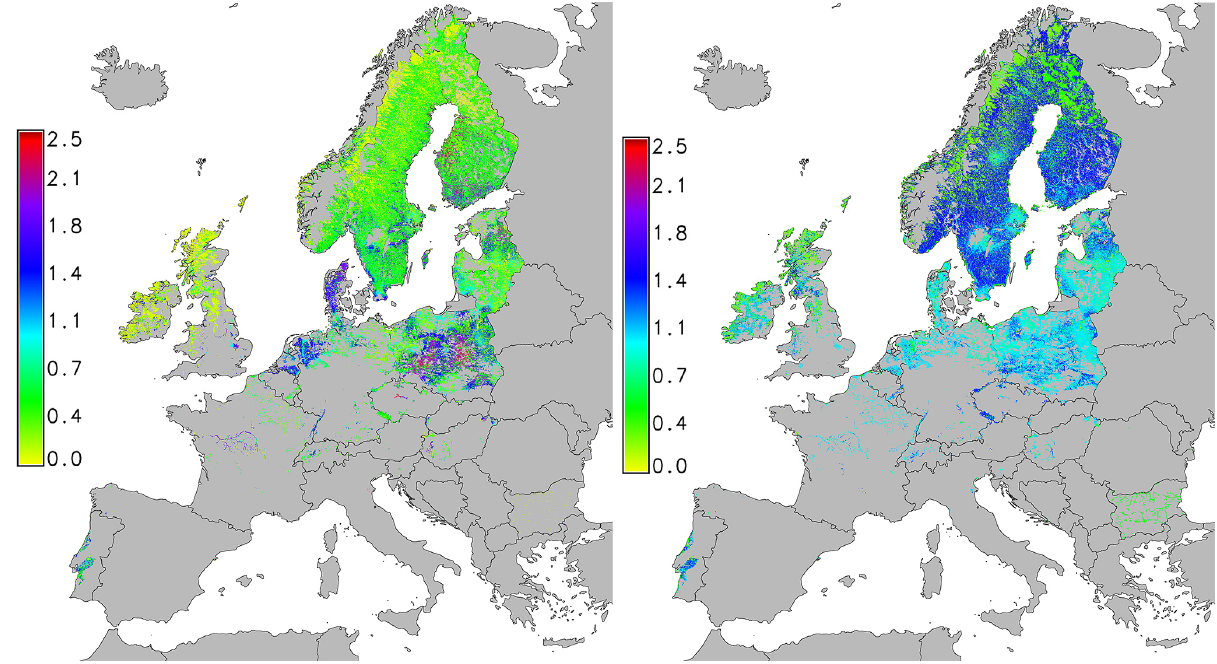
Figure 8. European N 2 O fluxes for 1km × 1km raster grid cells calculated with the fuzzy logic model approach (left) and the corresponding pixel-wise model uncertainty as standard deviations (right) for organic soils in gN 2 O-Nm − 2 a − 1 . The land use classification is based on CORINE land